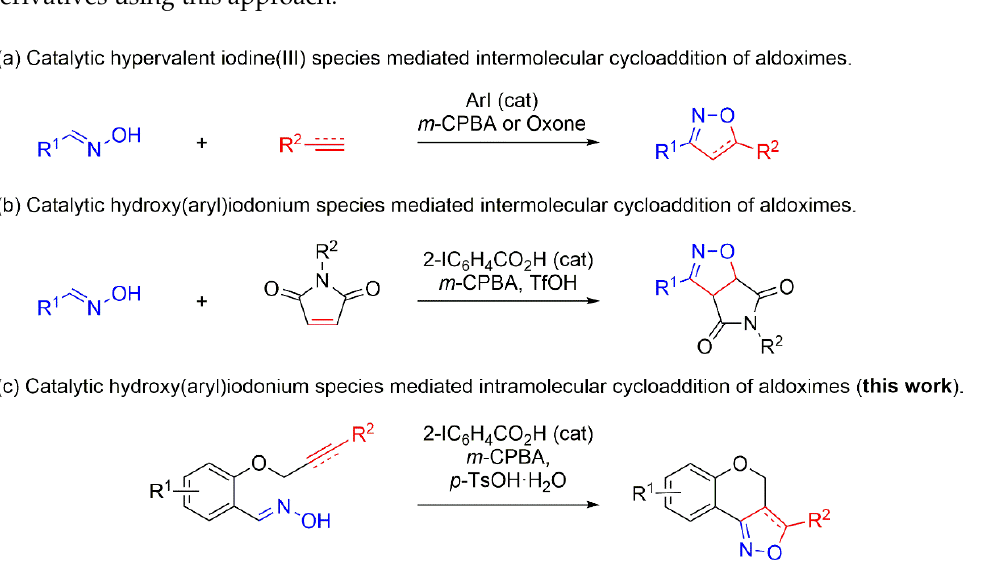
Figure 1. Reactions of aldoximes using catalytic hypervalent iodine(III) species.